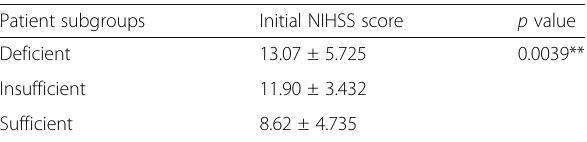
Table 3 Comparison between patient subgroups regarding NIHSS scores Patient subgroups